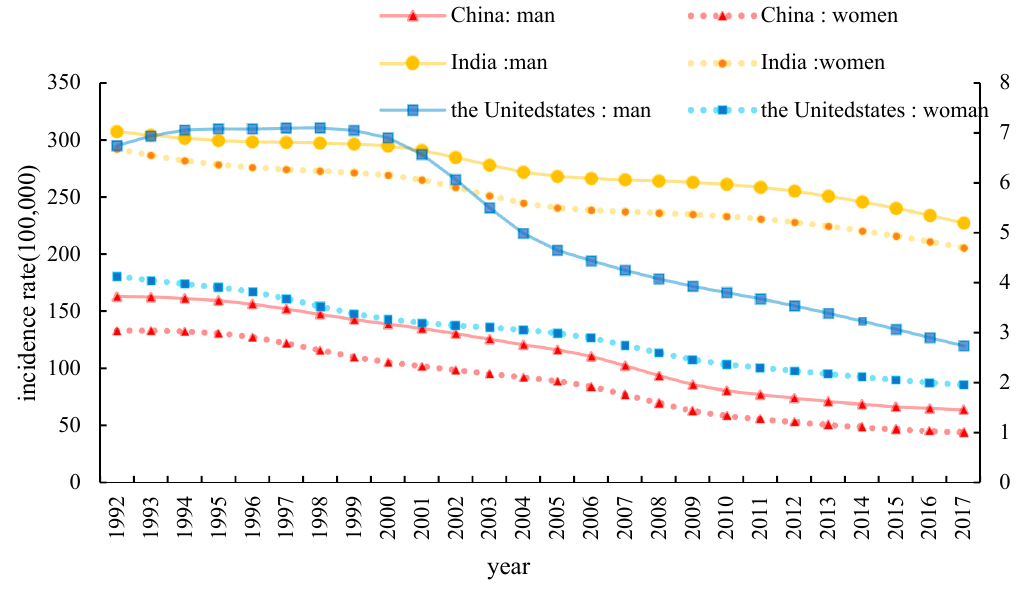
Figure 3. Trends in age-standardized rates for tuberculosis in men and women from 1992–2017 in China, India, and the United States.